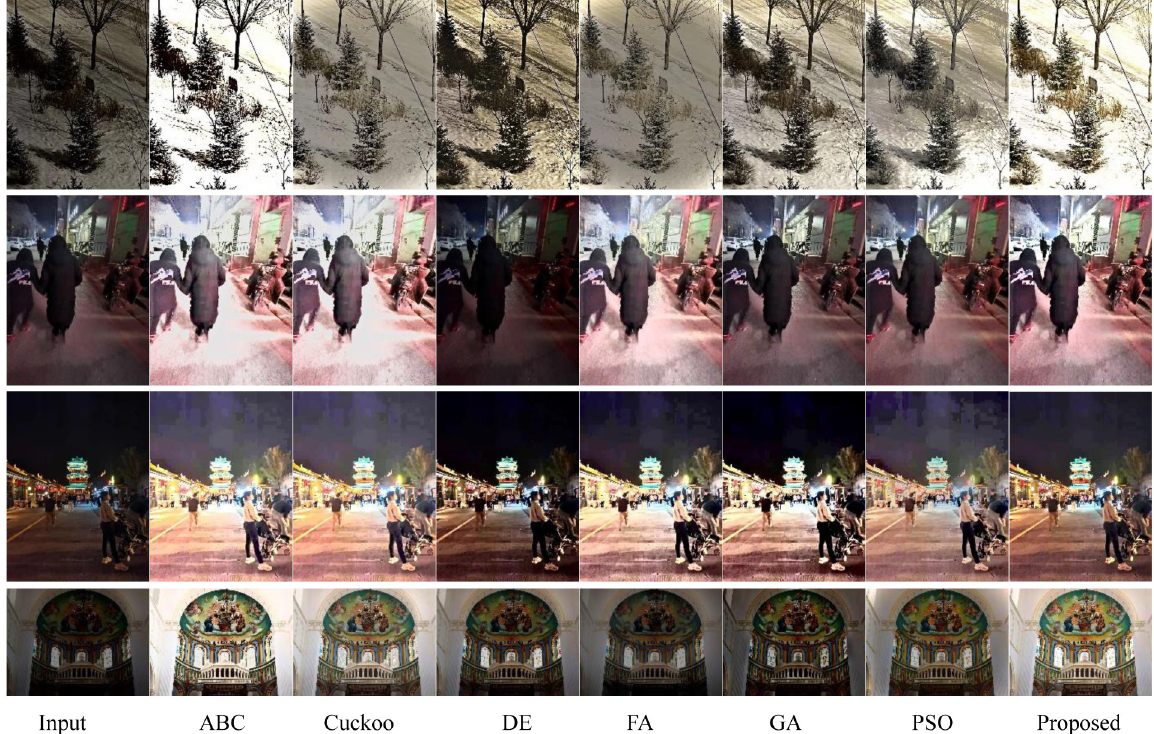
Fig 4. The visual quality performance comparison of the enhanced image obtained by various image enhancement approaches. The first column is the input images, the second to the eighth column are results of ABC, Cuckoo, DE, FA, GA, PSO, respectively. The last column is the results of the proposed approach. From top to bottom, the test images are images 1–4, respectively.